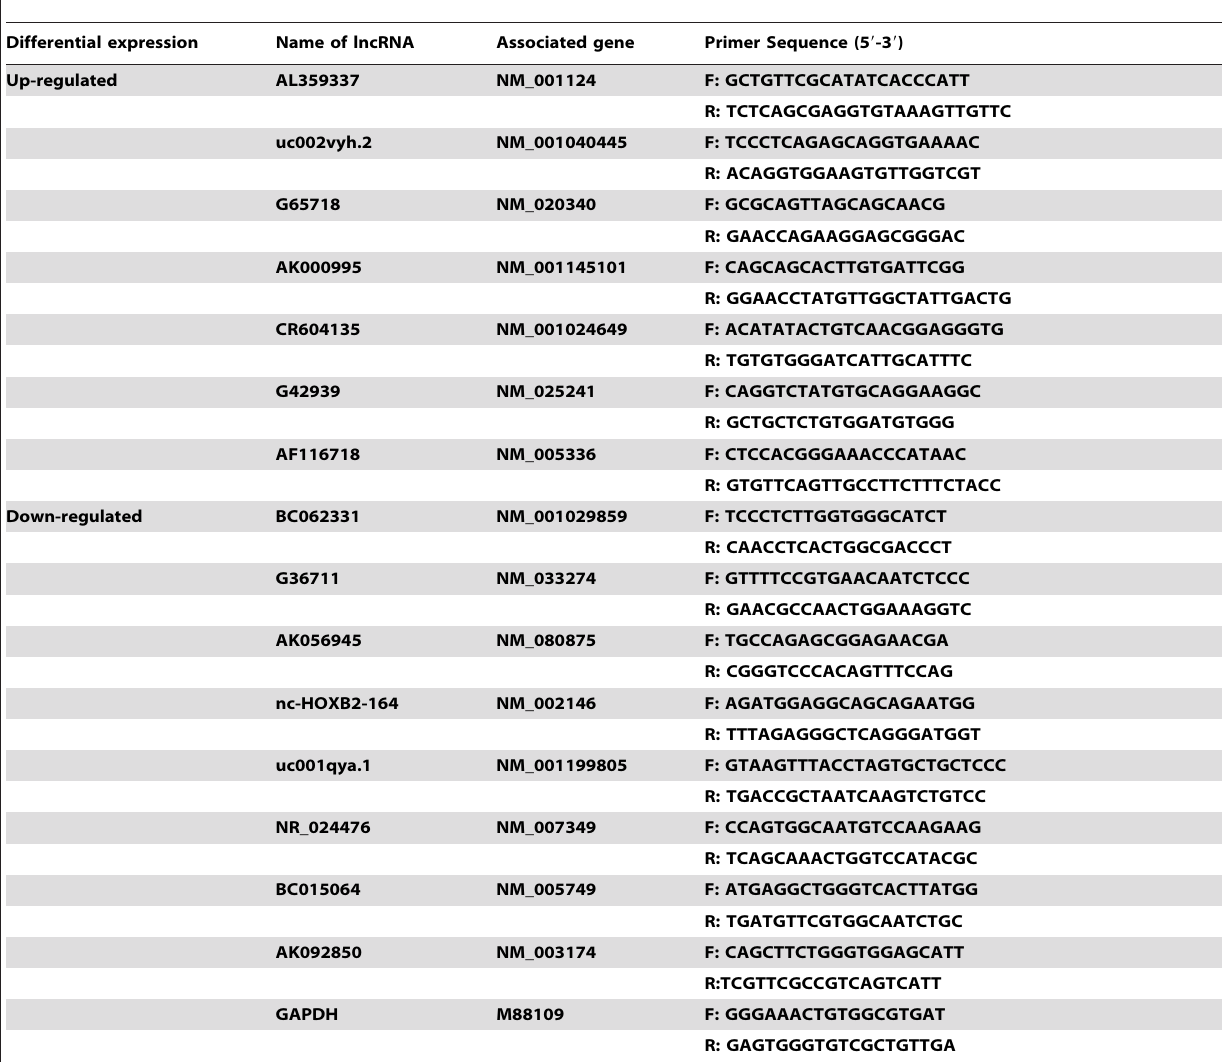
Table 2. RT-qPCR validation of differentially expressed